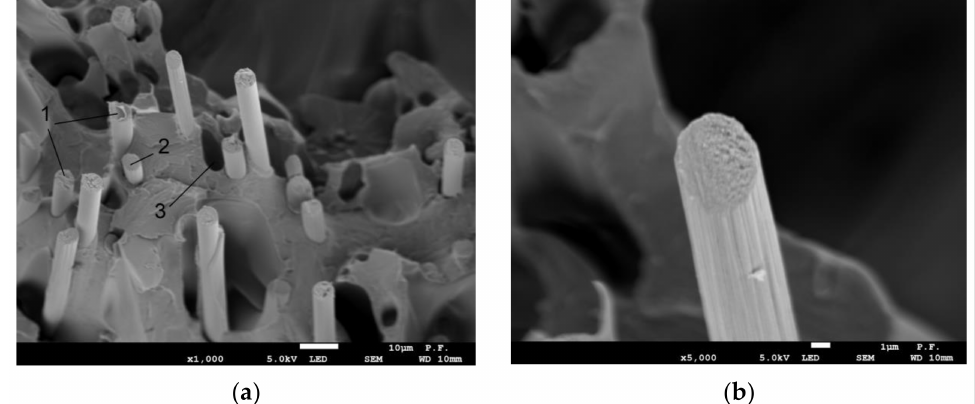
Figure 20. Cross-sectional views of a 1.8 mm thick PLA-CF specimen after fracture (axonometric view), ( a ) × 1000 magnification, 1—broken fibers, 2—non-damaged fibers that partly slid out of the base material, 3—hole where a carbon fiber was, ( b ) × 5000 magnification—a single carbon fiber reinforcing